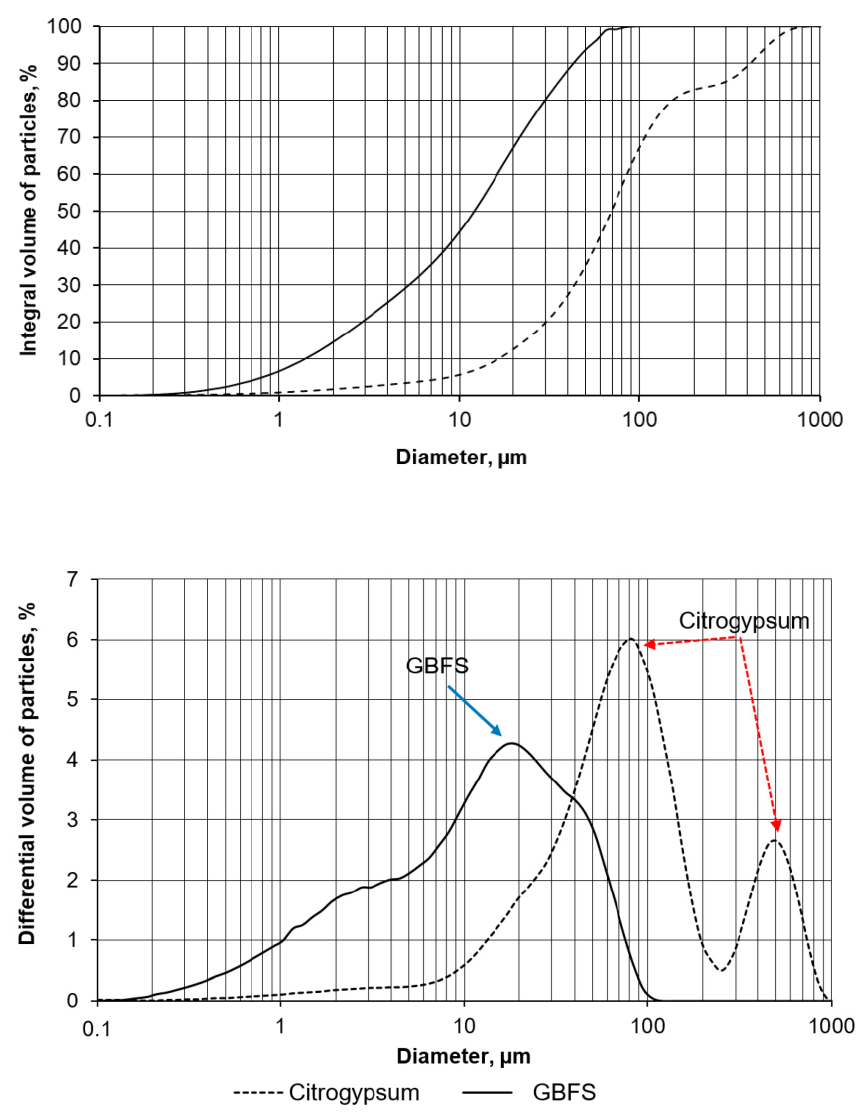
Figure 6. Granulometry of citrogypsum and ground GBFS.